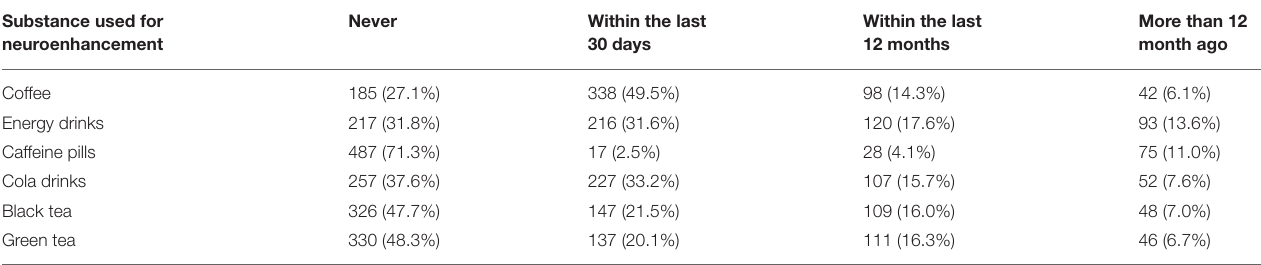
TABLE 4 | Prevalence rates for the use of legal neuroenhancement substances. Substance used for neuroenhancement